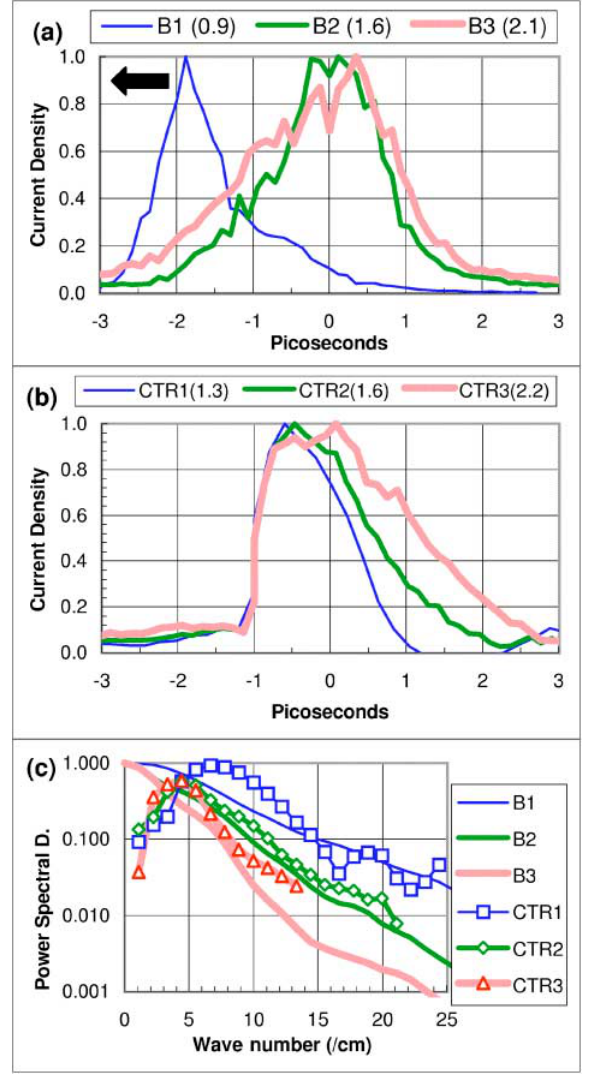
FIG. 4. (Color) Comparison of off-phase acceleration and CTR bunch shape measurements. (a) At three different accelerator settings, bunch shapes B1, B2, and B3 were observed by the new off-phase acceleration method. The peak heights have been normalized for ease in identifying their full width at half maximum (FWHM), given in parentheses (in picoseconds) for each bunch. The black arrow in the upper left indicates the direction of bunch travel (leading edge). (b) The shapes of the same three bunches were reconstructed by a CTR spectral method, which recovered the correct length and degree of asymmetry for bunches B2 and B3, but could not distinguish between the original bunch shape and its temporal reflection. The spectral method also failed to discover the sharpness of the peak and the shallow tail of bunch B1. (c) On a log scale, the normalized numerical power spectra of measured bunch shapes B1–B3 are compared with the measured CTR spectral data CTR1–CTR3 to show how detector response may affect bunch shape